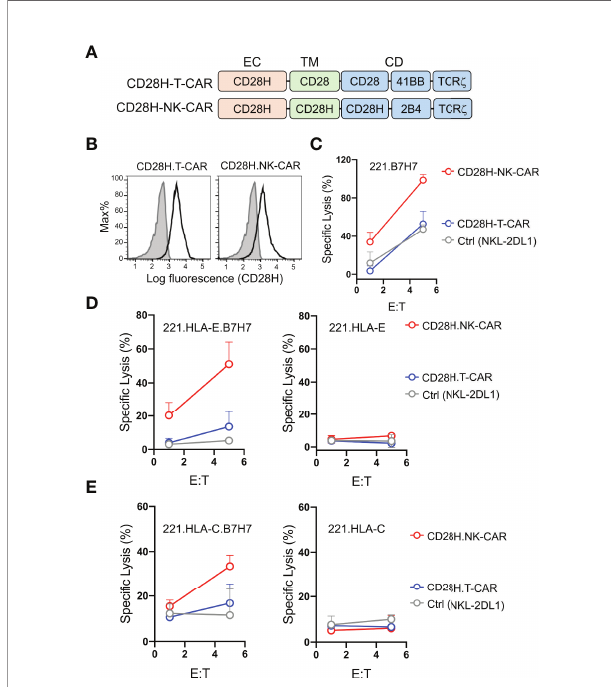
FIGURE 3 | Lysis of B7H7 + HLA-I + tumor cells by NK cells that express CD28H-CARs. (A) Schematic diagram of CAR constructs consisting of the extracellular domain of CD28H and the indicated combinations of signaling domains. (B) Flow staining to determine expression of CD28H.T-CAR, CD28H.NK-CAR and CD28H.CAR3 in NKL.2DL1 cells. (C) Lysis of 221.B7H7 cells by NKL.2DL1 expressing CD28H. CARs. (D) Killing assays using CAR-transduced NKL.2DL1 cells as effector and 221.HLA-E cells or B7H7-transfected 221.HLA-E cells as targets (n=2). (E) Lysis of 221.HLA-C (Cw15) cells or B7H7-transfected 221.HLA-C (Cw15) cells by NKL.2DL1 cells expressing CD28H.CARs